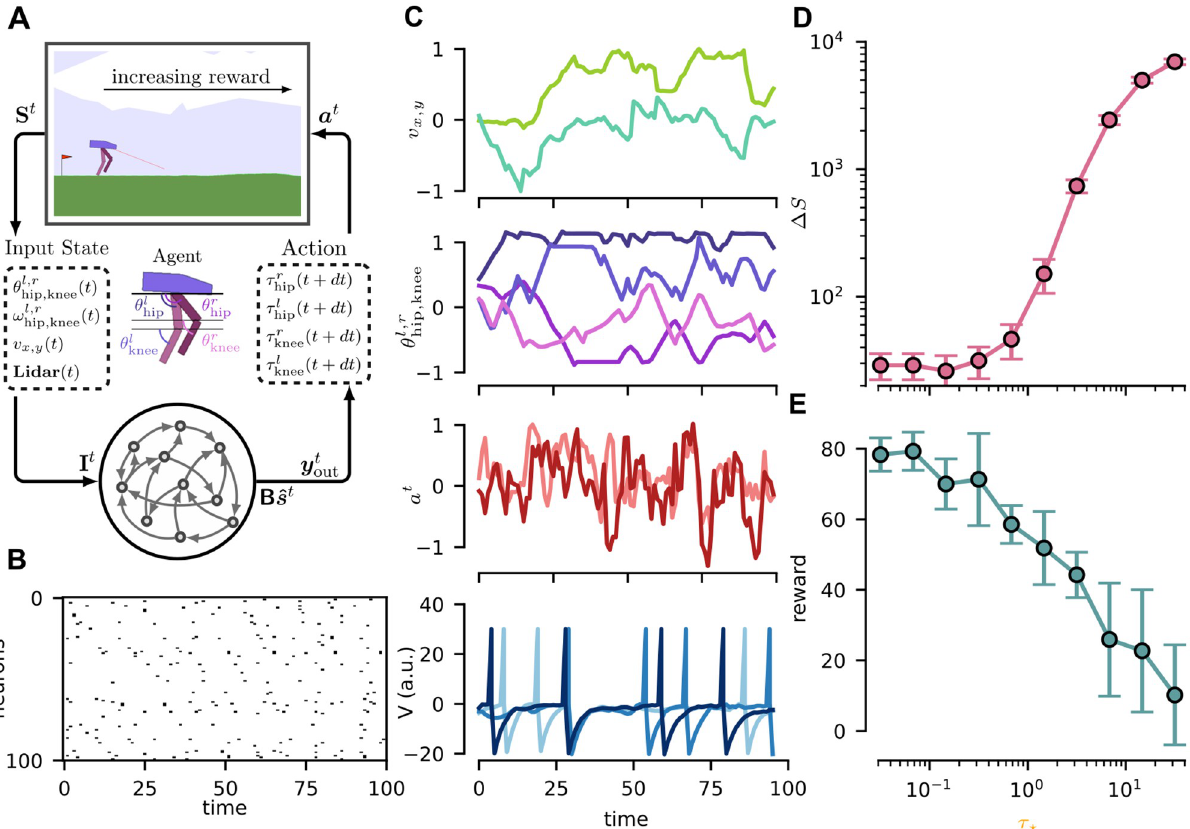
Fig 5. 2D Bipedal Walker. ( A ). Representation of the 2D Bipedal Walker environment. The task is to successfully control the bipedal locomotion of the agent, reward is measured as the travelled distance across the horizontal direction. The agent receives a state vector containing several measurements such as joints position, velocity and LIDAR for environment sensing and outputs the torque vector for the four leg joints. ( B ) Rasterplot of the activity of a random sample of 100 neurons across T = 100 time unit of a task episode ( C ) Temporal dynamics of a subset of the core input state variables, action vector and spike dynamics. Top panels report respectively: v x , y , the velocity vector in the bi-dimensional plane, y l ; r with colors matching the scheme of panel A , and the action vector a t containing the torque τ hip,knee for the two joints of the left leg. (Bottom) Temporal dynamics of membrane potential for three randomly sampled neurons. ( D ). Average spike error Δ S as a function of the τ ? . Error bars represent the standard deviation of the mean. ( E ). Average final episode reward as a function of the τ ? . Error bars represent the standard error.